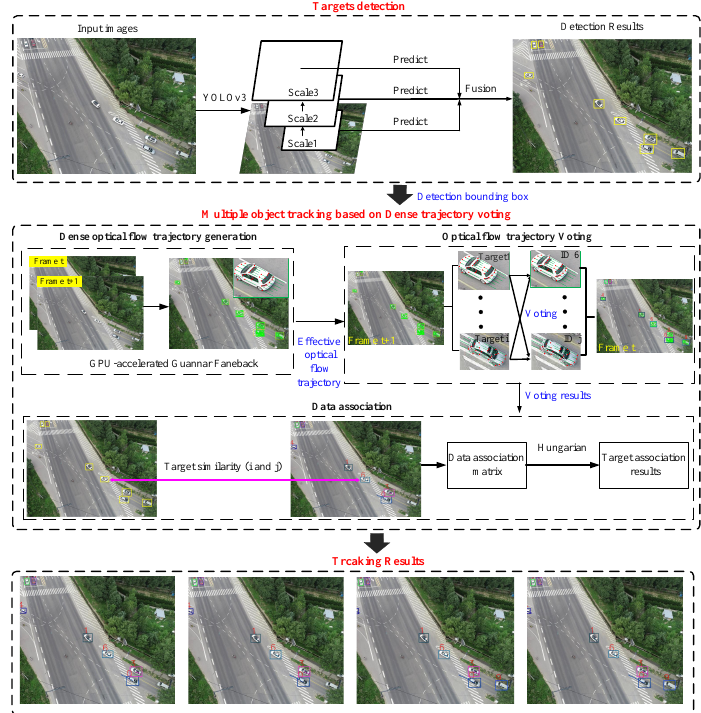
Figure 2. Overview of proposed multiple-object-tracking algorithm based on dense-trajectory voting in aerial videos. The algorithm mainly consists of two sections, target detection and object tracking based on dense-trajectory voting. Object tracking includes dense-optical-flow-trajectory generation and voting, and data association based on dense-trajectory